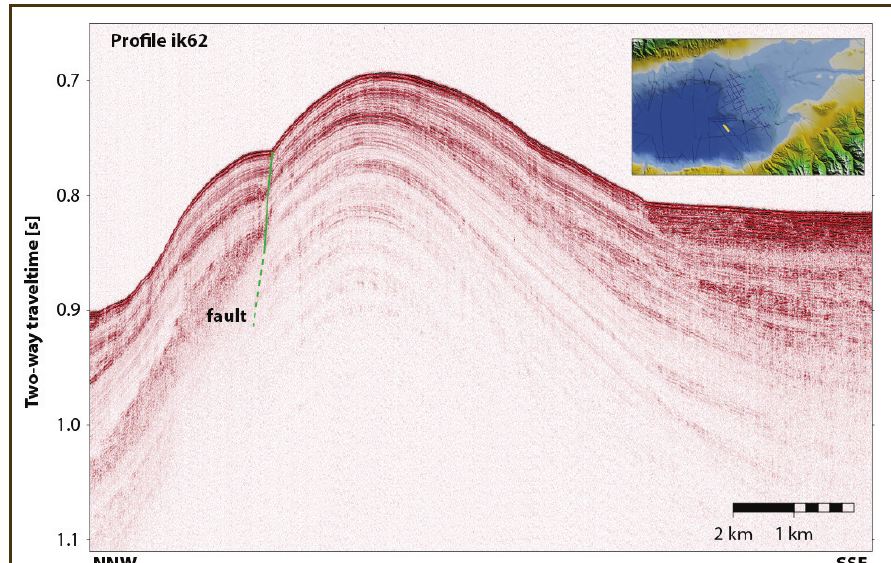
Figure 3. Seismic section that shows a subtle rise in bottom topography and with undisturbed sediment. (De Batist, M., unpublished; compiled by C.